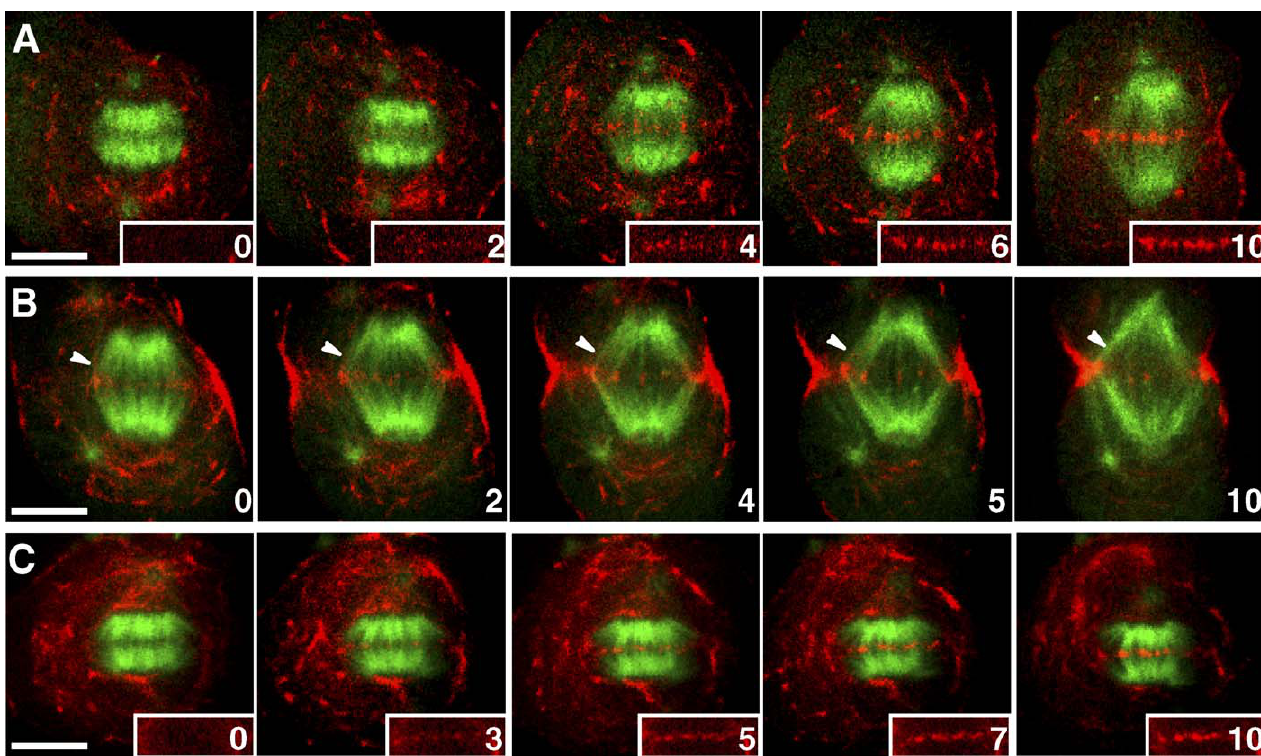
Figure 5. Interdigitating Microtubule Plus Ends Hosted De Novo Actin Assembly and Delivered Actin Aggregates to Equator (A) Emergence (0–2) and growth (2–10) of nascent actin fluorescence at the equatorial microtubule plus-end overlap region reflect de novo assembly of actin aggregates. (B) A splaying microtubule bundle (arrowheads) delivered the actin aggregate into the ingressing furrow. Cells in (A) and (B) were labeled as in Figure 1B. (C) De novo assembly of actin aggregates was not inhibited by microtubule stabilization (compare to (A) and Figure 1B). Microtubules were labeled and stabilized by Oregon green paclitaxel, and actin filaments were labeled by rhodamine phalloidin. Insets: actin channel. Time in min. Time 0 in (A and C), immediately before anaphase onset; in (B), late anaphase. Bars, 10 l m.